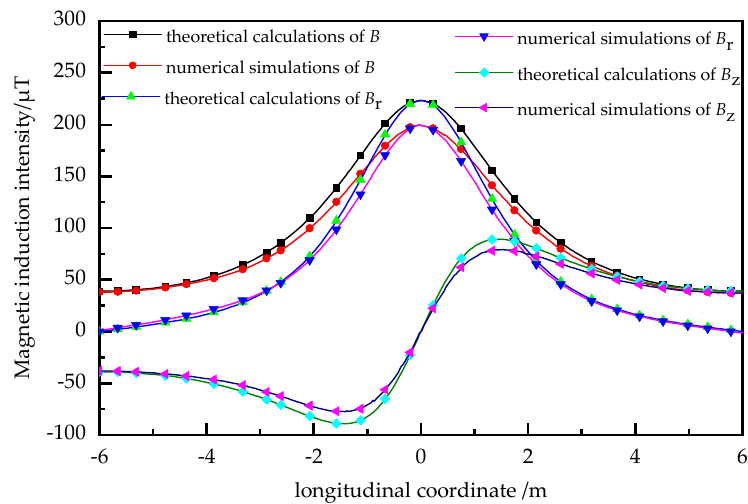
Figure 4. Variations of magnetic induction intensity and its components along the longitudinal test line (radial distance ρ = 2 m) under N–N connection condition.